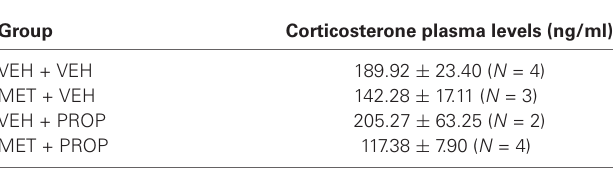
Table 2 | Corticosterone plasma levels of animals submitted to different treatments.